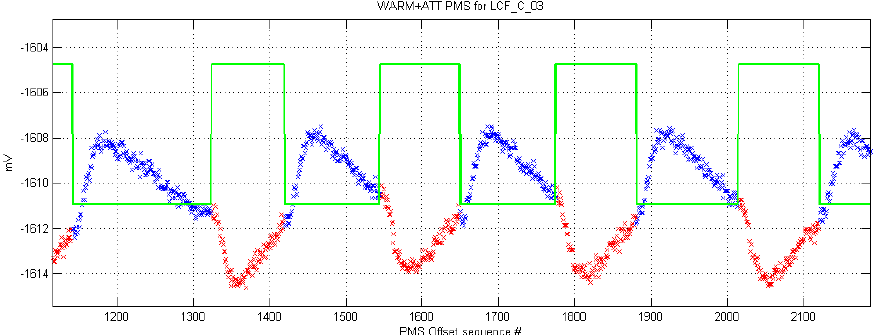
Figure 6. SMOS PMS gain for receiver LCF_C10 over the years. The blue line indicates the value as measured during the calibration event at the physical temperature during the calibration event. The cyan line and black line show the PMS gain transported to 21 degrees Celsius using the second mission reprocessing and pre-launch PMS sensitivities, respectively.